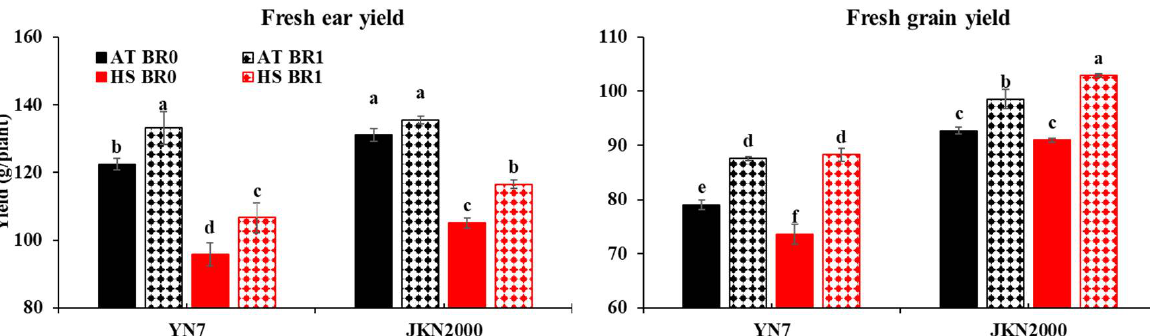
Figure 1. Effects of foliar BR application at the silking stage on ear and grain yields of fresh waxy maize under post-silking ambient and high temperatures. AT, ambient temperature; HS, heat stress; BR0, application of water; BR1, application of 0.25 mg/L BR. The different letters on the column mean the difference was significant at the p < 0.05 level.